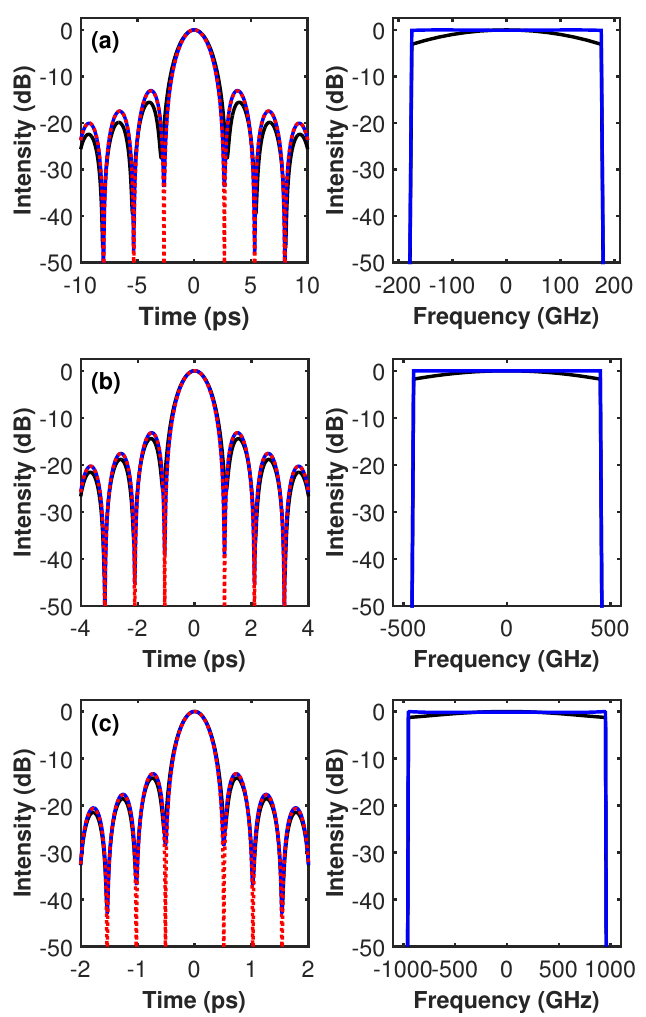
Figure 4. Temporal ( left ) and spectral ( right ) intensity profiles of the output pulse from = 2 . 5 ps ); ( b ) B = 1 THz the laser for different filter bandwidths: ( a ) B = 400 GHz ( τ p = 1 ps ); and ( c ) B = 2 THz ( τ = 0 . 5 ps ). The profiles obtained with a flat-top ( α = 0 ) ( τ p p spectral pulse shaper (black) are compared to those obtained with a convex Gaussian-top spectral shaper (blue). The correction factor is α = 6 . 1 , 1 . 1 , 0 . 18 in ( a–c ), respectively. Also shown are the calculated waveforms according to (3) (red dotted). A laser without dispersion control in the cavity is modelled. Adapted from [36]. Copyright 2015,